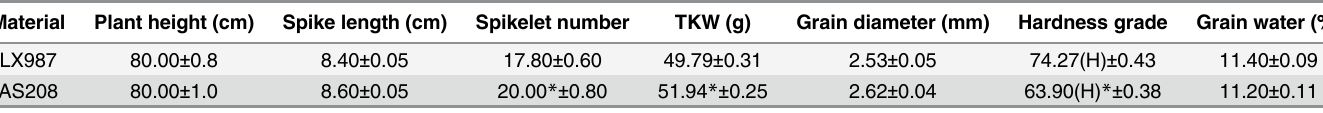
Table 1. Comparison of main agronomic and grain traits between AS208 and LX987. Material Plant height